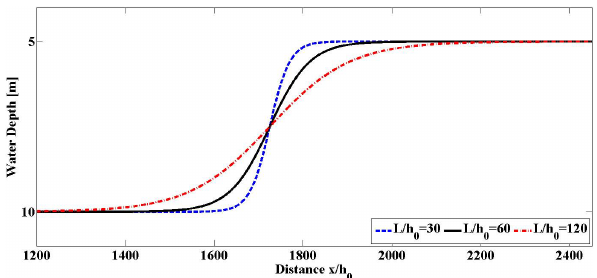
Fig. 6. Depth profile (7) with various length of the transitional zone L / h 0 .